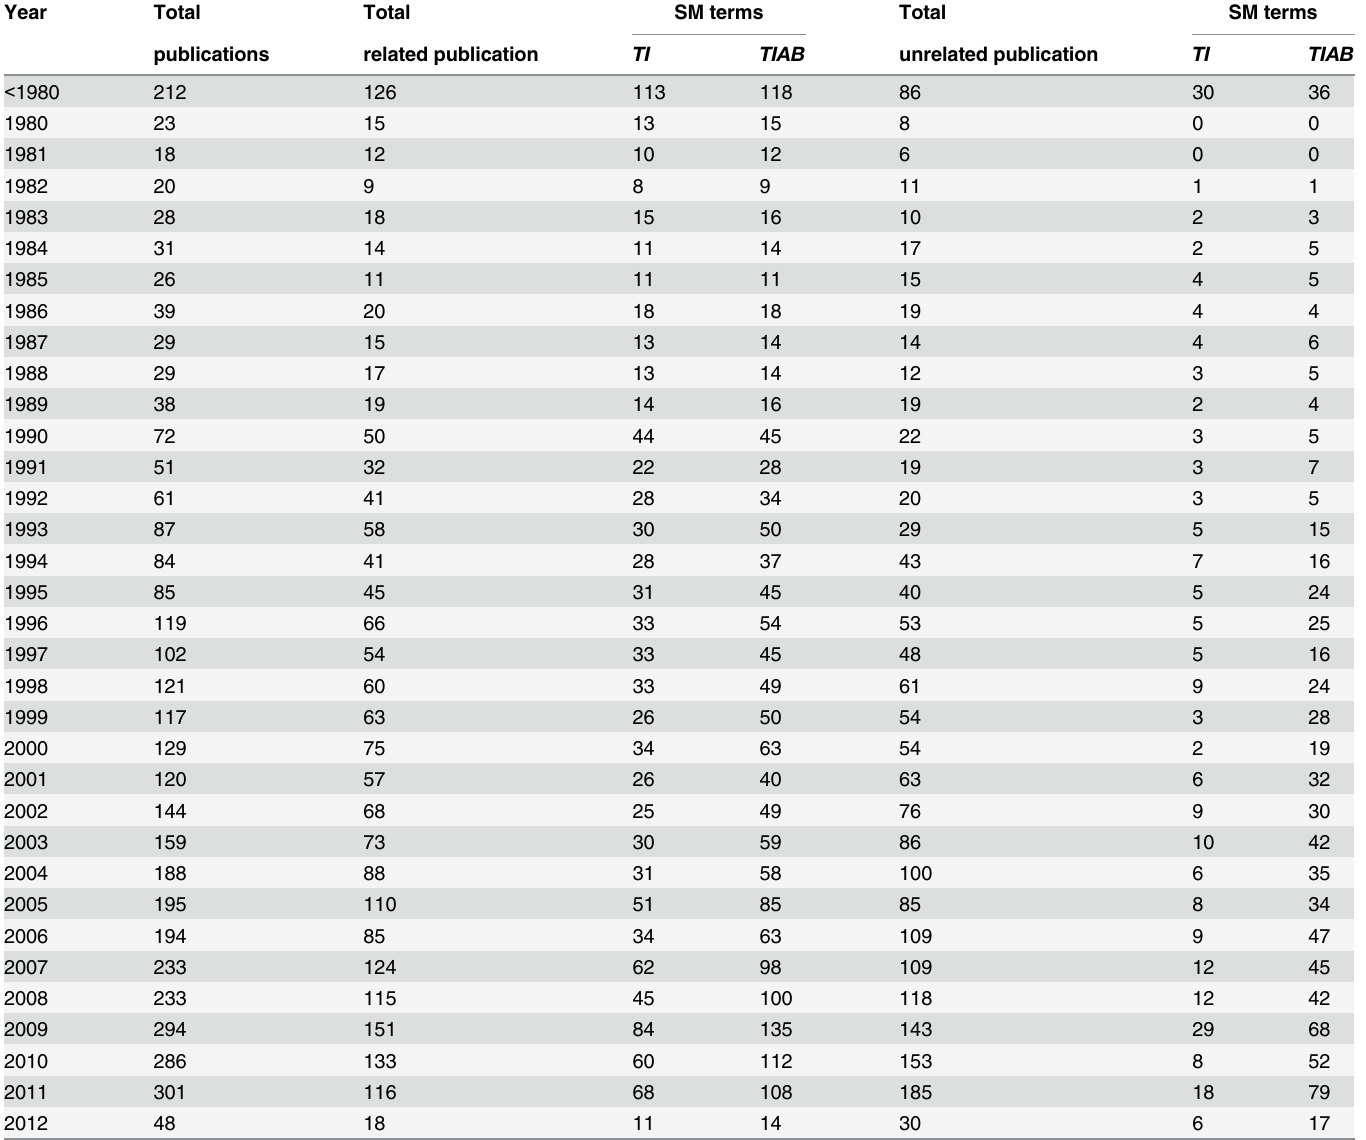
Table 1. Frequency of publications with SM terms in TI and TIAB of related and unrelated publications in each